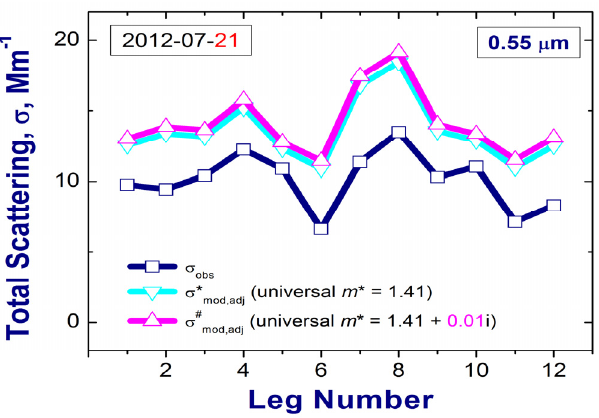
Figure 12. Total scattering coefficient at 0.55 µm wavelength measured (navy blue) and calculated (cyan, magenta) for size distributions measured on 21 July, 2012 and corrected using two assumed universal RIs: m * = 1.41 (cyan) and m # = 1.41 + 0.01i (magenta).